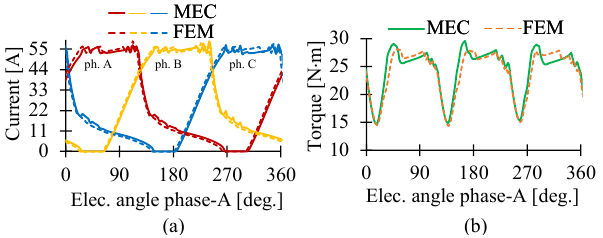
Figure 22. Dynamic characteristics at 5460 r/min at 385 V DC: ( a ) phase currents I ref = 55 A, θ ON = − 52.5 ◦ , and θ OFF = 125 ◦ and ( b ) developed electromagnetic torque.